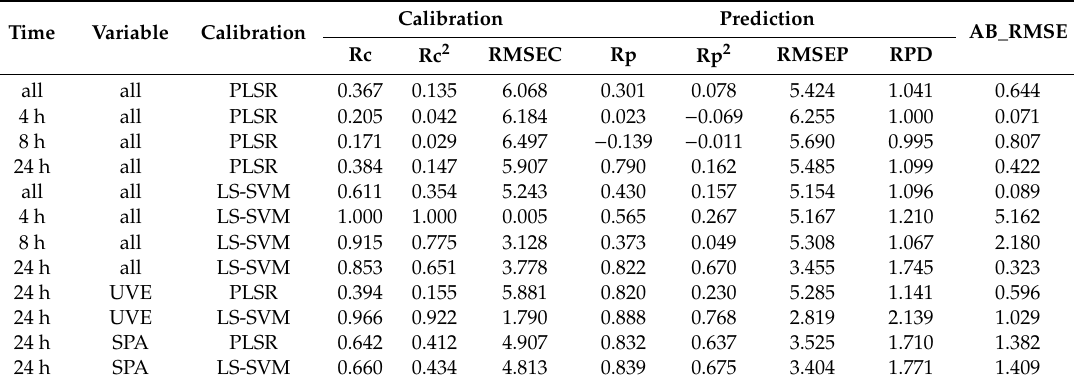
Table 3. Detection of levels of compression